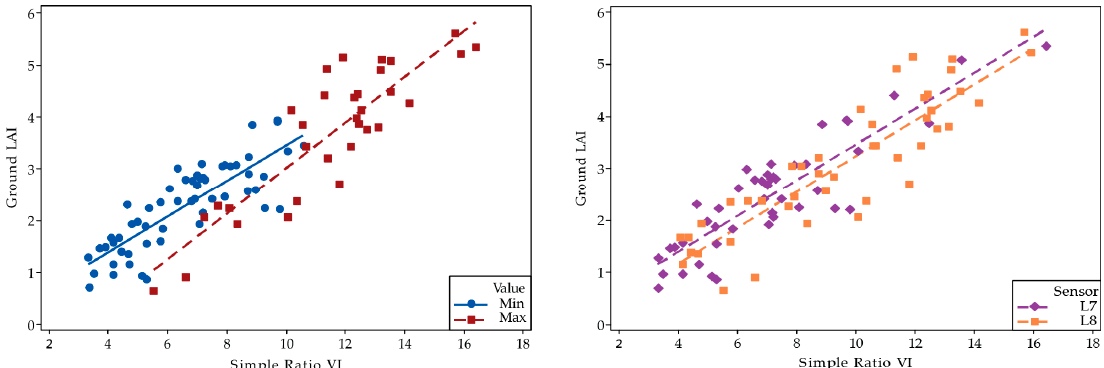
Figure 4. Regression models with closest in time imagery regardless of sensor and all ground data from both minimum and maximum LAI. The blue circles are the minimum LAI and the red triangles are the maximum LAI data points. The different sensor data points are differentiated by purple diamonds (ETM+) and orange squares (OLI).